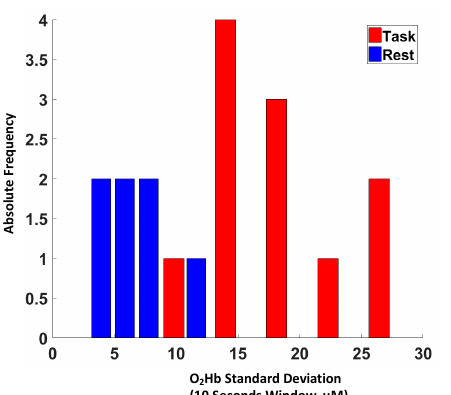
Figure 4. Example of histograms of standard deviations of oxyhemoglobin (O 2 Hb) for a voxel evaluated at a 10 s integration window during rest (blue bars) and the Symbol Search (SS) test (red bars). A clear increase in the average variability in O 2 Hb of a few µ M is visible during the task, depicting plausible hemodynamic brain activity in the selected voxel.